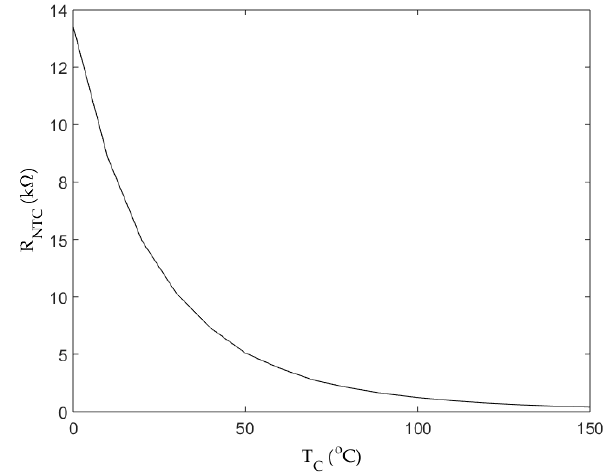
Figure 13. Infineon temperature characteristic of the NTC thermistor [30]. Table 3. Inverter performance f sw = 25 KHz.